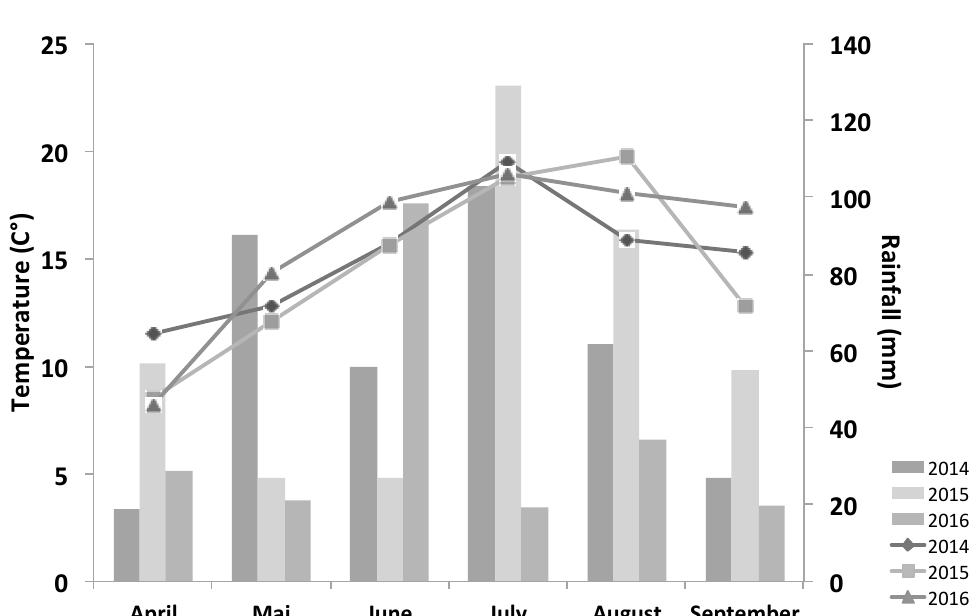
Figure 1. Climatograph for Göttingen, Germany. The columns indicate the total rainfall (mm) and the lines the average temperature (°C) for each month in the growing season during the study period (2014–2016). Data source: DWD Climate Data Center [28].